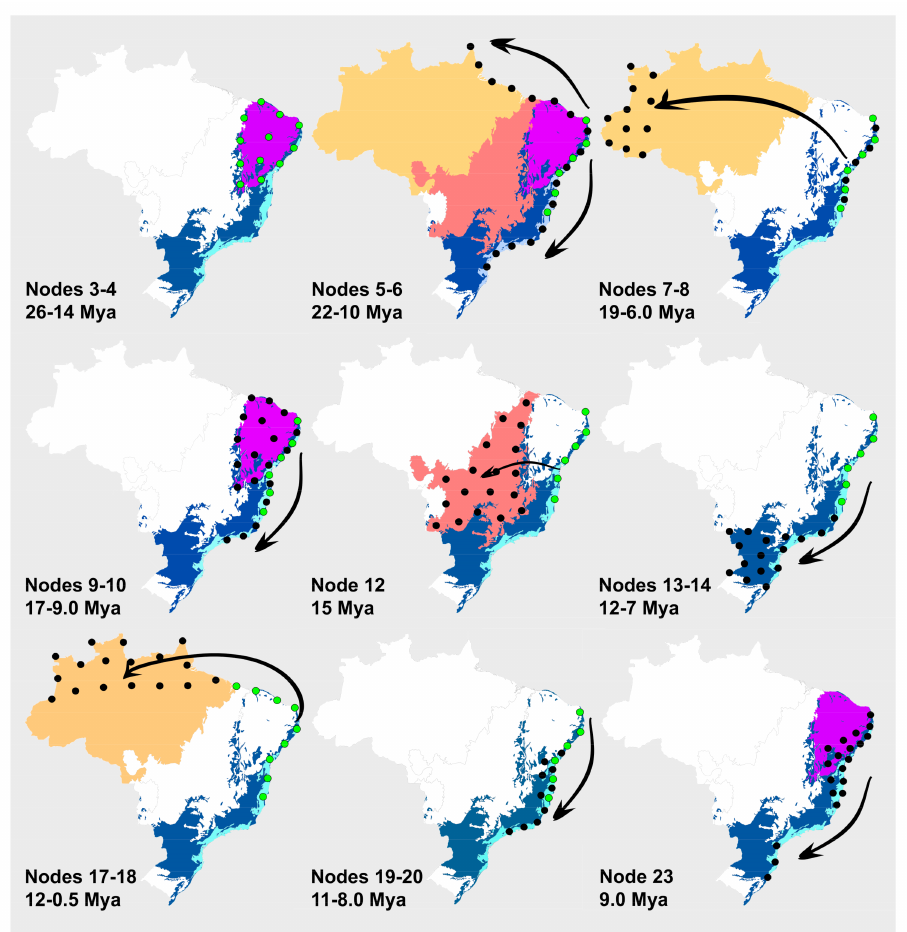
Figure 3. Times of dispersal / vicariance events leading to biome shifting in Stigmaphyllon . (blue) Atlantic rainforest; (purple) Seasonally Dry Tropical Forest; (orange) Amazon Rainforest; (red) Cerrado. Green circles represent the original ancestral populations of Stigmaphyllon . Dark circles represent populations of Stigmaphyllon colonizing new biomes over di ff erent time periods. Table 1. Divergence times estimates (maximum / mean / minimum), ancestral area reconstructions, and dispersal / vicariance events reconstructed for all nodes in this study.